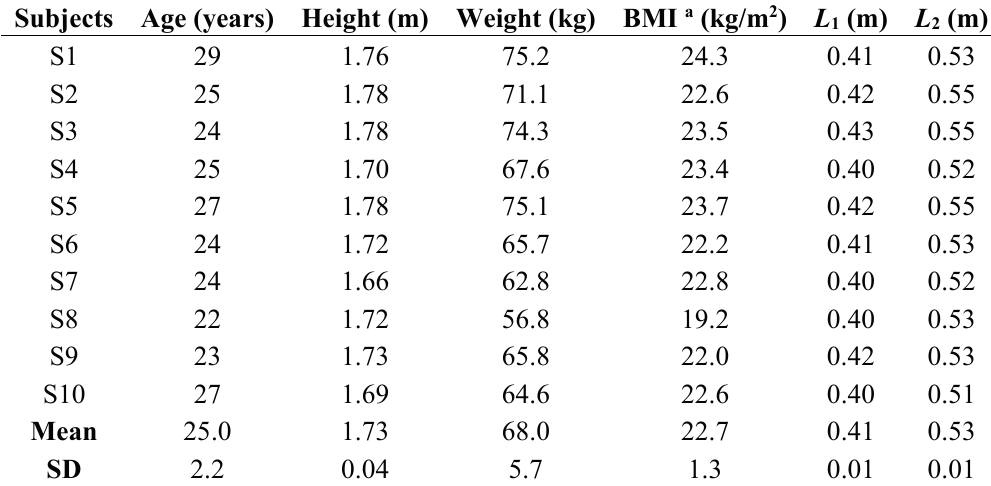
Table 2. Subject